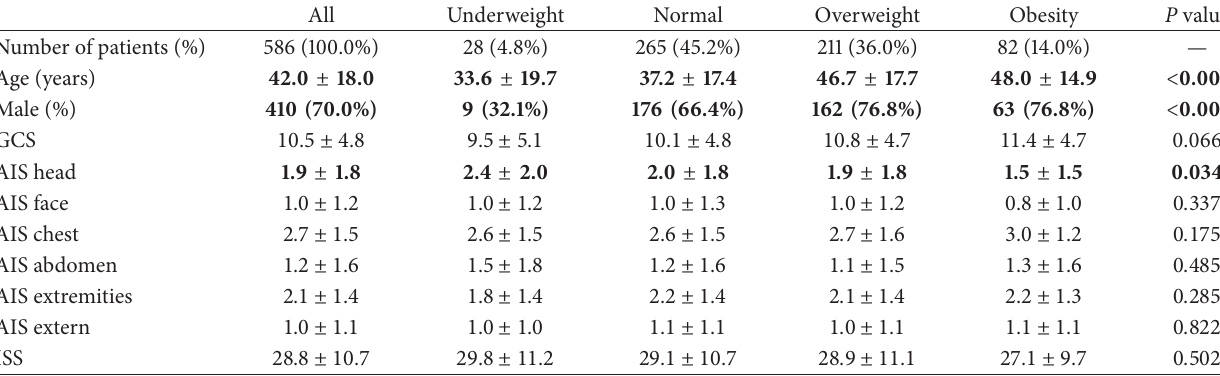
Table 1: Study population and characteristics according to the BMI.